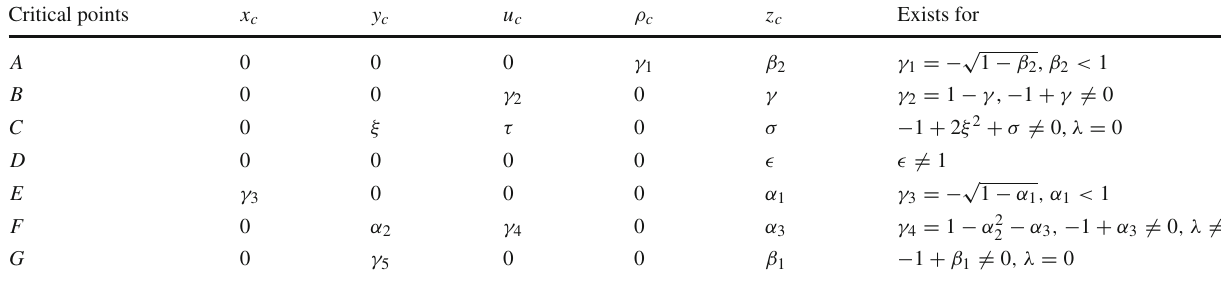
Table 4 Critical points for dynamical system